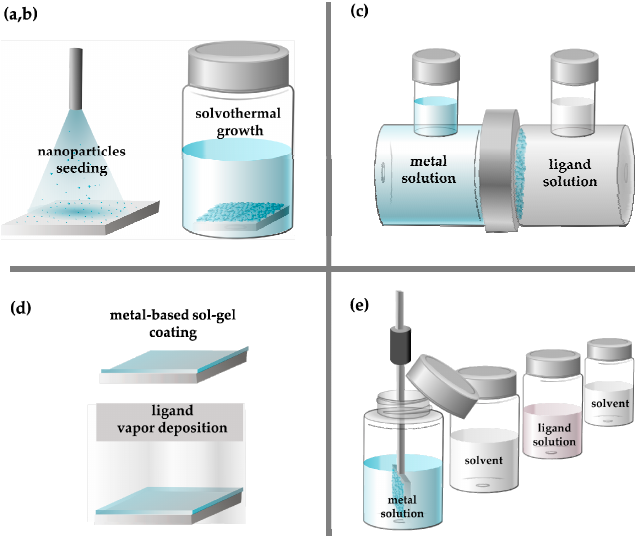
Figure 2. Schematic representation of the MOF membrane preparation methods, like solvothermal growth method and seeding ( a , b ), counter diffusion ( c ), gel-vapor deposition ( d ), and layer-by-layer ( e ).